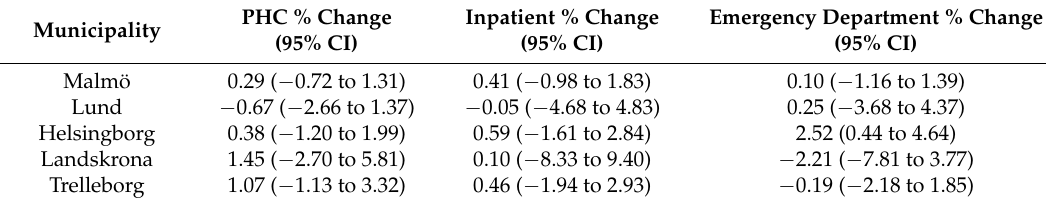
Table 5. Percent change in the number of visits to PHC clinics, inpatient admissions, and emergency department visits with 95% CIs associated with a 10 µ g/m 3 increase in PM 10 lag 0–2 in five municipalities during 2005–2010 in multi-pollutant